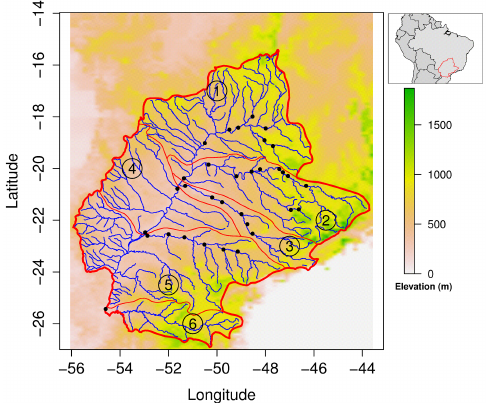
Figure 1. The Paraná River basin (red contour) and streamflow gauges used in this work (black dots). The elevation is in meters and the location of the Paraná River basin within Brazil is shown in the smaller panel in the upper right corner (red line contour). The thinner red line shows the associated subbasins: (1) Paranaíba, (2) Grande, (3) Tietê, (4) Paraná, (5) Paranapanema–Paraná, and (6)